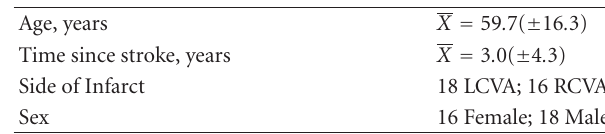
Table 1: Demographics of participants ( n = 34).